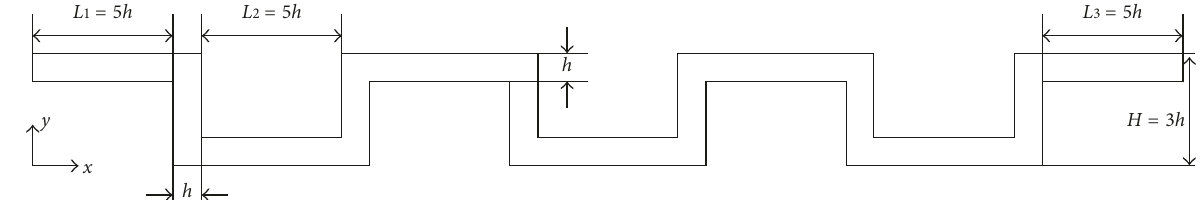
Figure 1: Physical model of the present work.